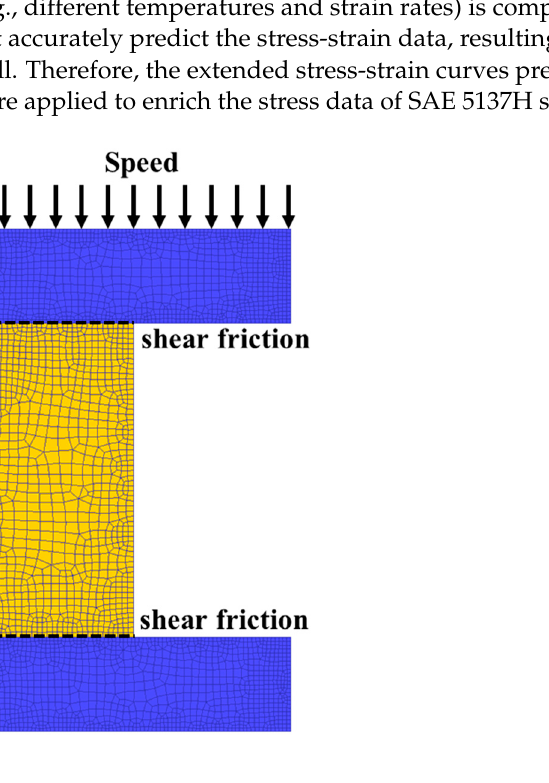
Figure 14. Finite element model for isothermal compression test.